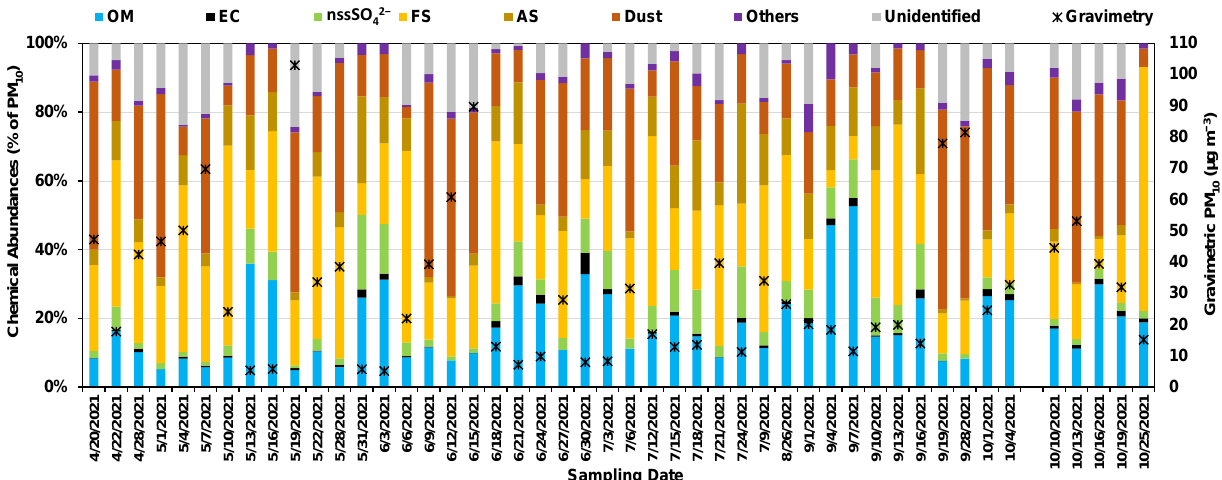
Figure 11. PM 10 mass percentages of chemical constituents (stacked bars) and gravimetric mass ( ∗ ) for the days sampled between April and October 2021.